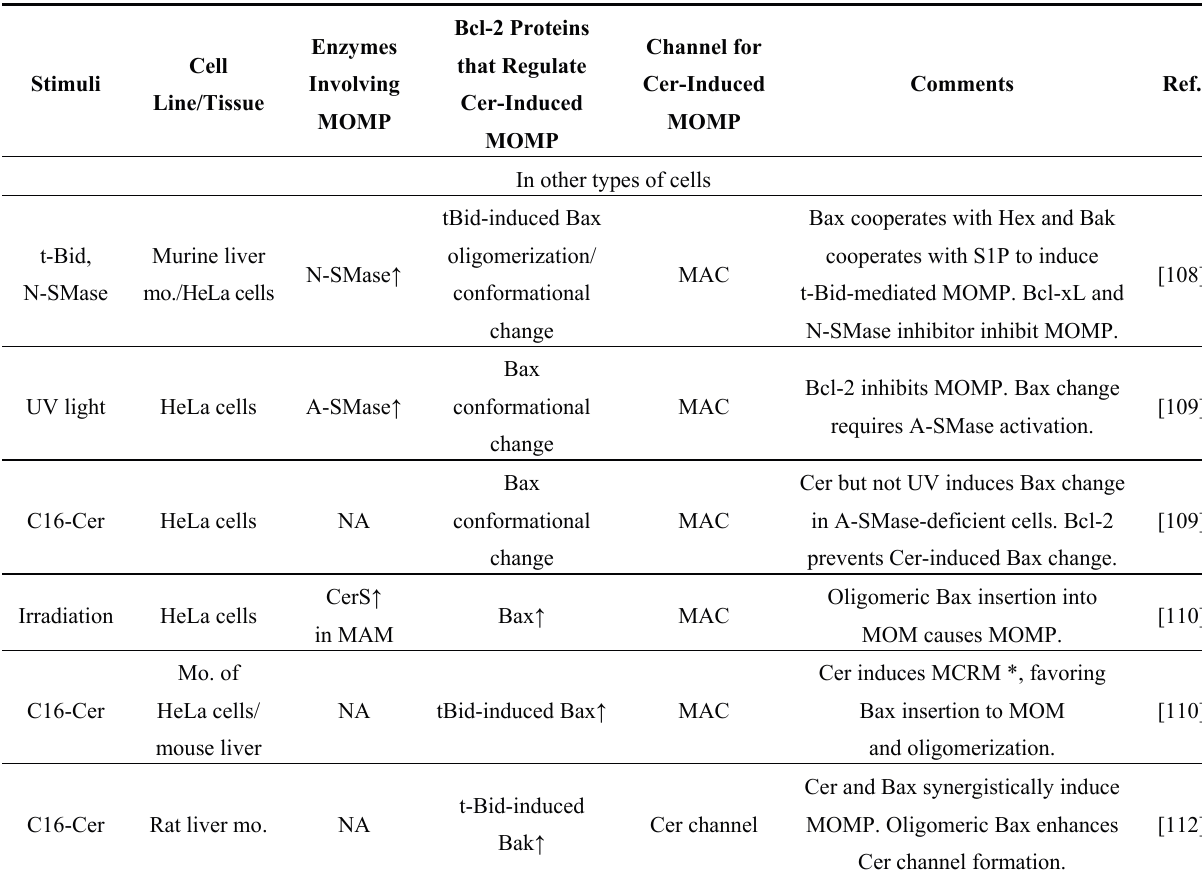
Table 2. Regulation of ceramide-induced mitochondrial outer membrane permeability (MOMP) by Bcl-2 family